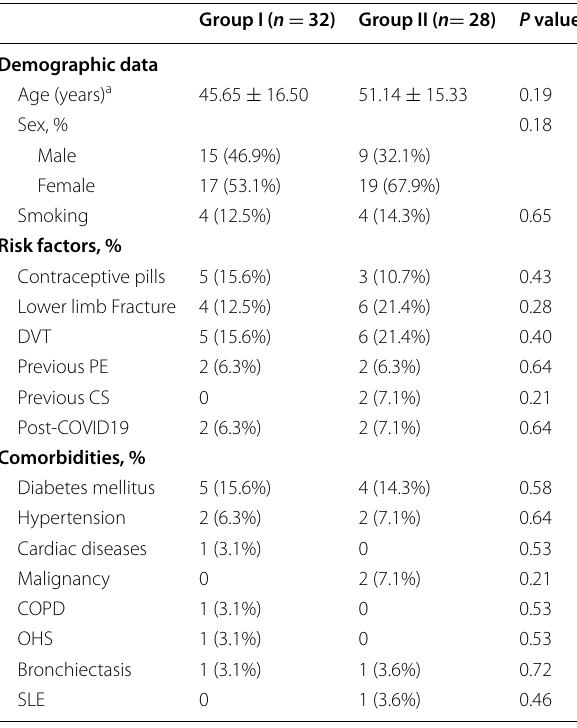
Table 1 Demographic data, risk factors, and comorbidities of the studied patients